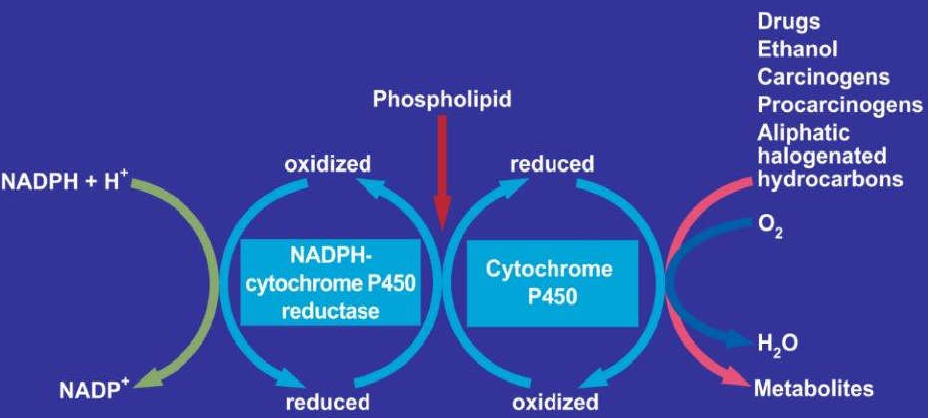
Figure 17. Risk factors of exogenous substrates for alcoholic fatty liver. At the stage of alcoholic fatty liver, and due to microsomal induction of cytochrome P450, various exogenous substrates are increasingly metabolized, leading to additional liver injury or to decreased blood drug